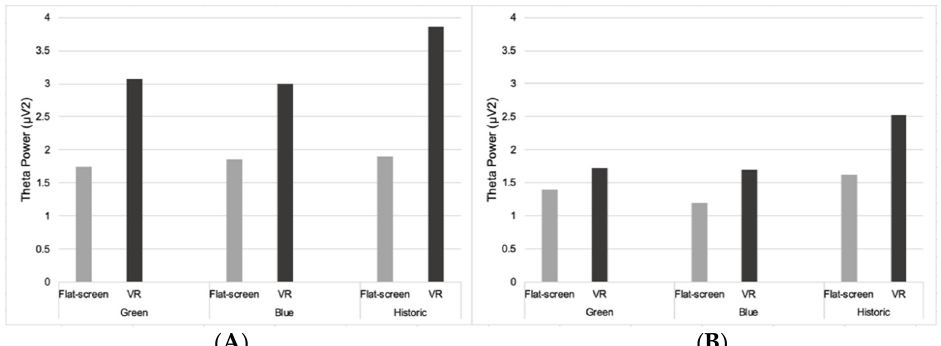
Figure 4. Theta power (µV ² ) in the overall frontal ( A ) and occipital ( B ) regions.